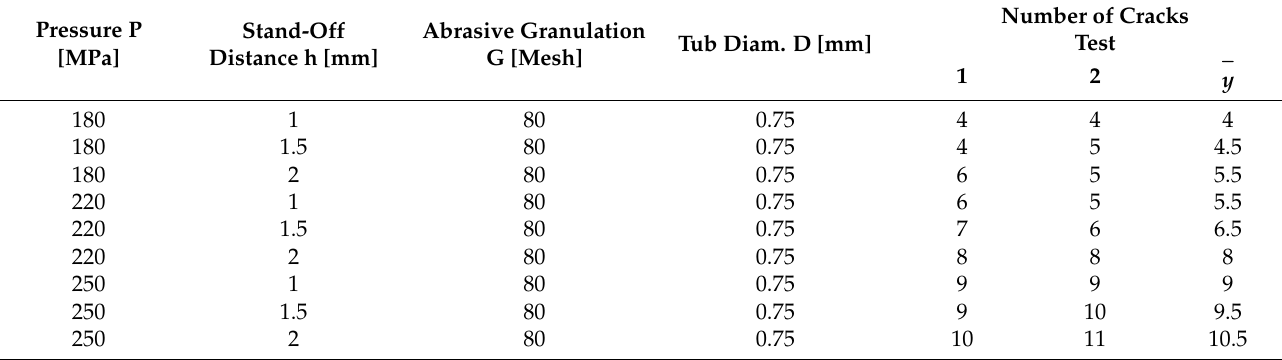
Table 3. Number of cracks depending on pressure and stand-off